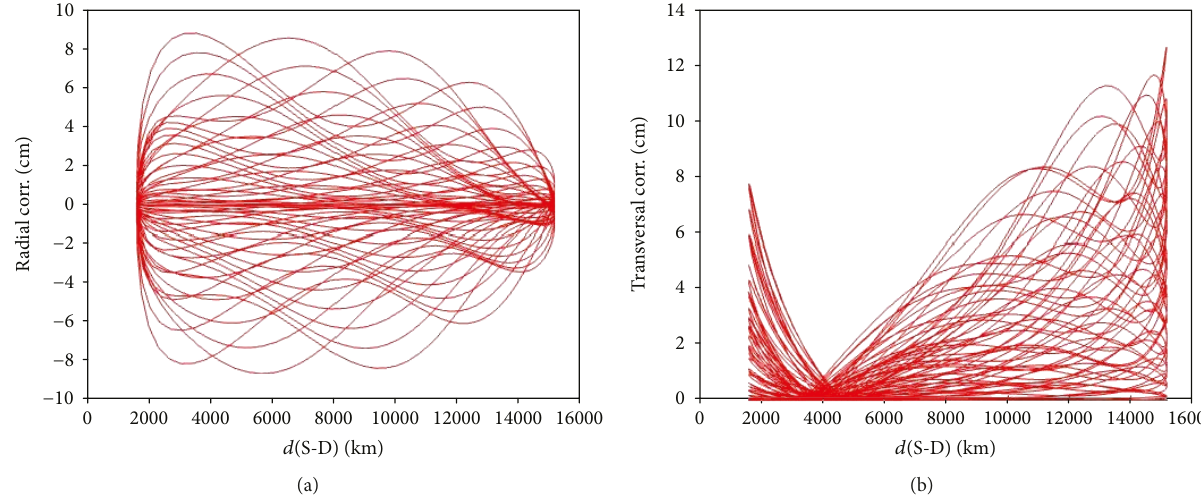
Figure 4: (a) Radial and (b) transverse p-N corrections versus the distance from S to D with TOL